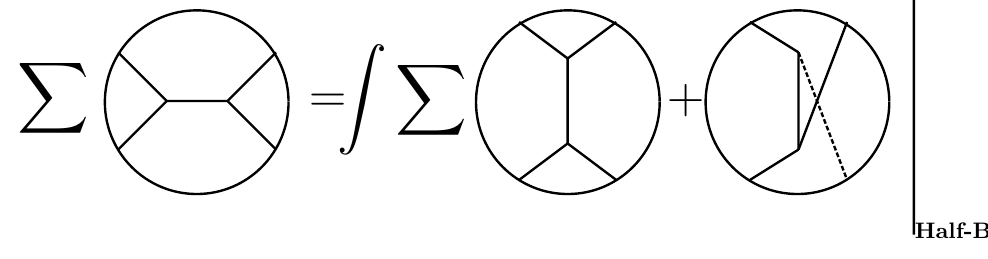
Figure 2 . s -channel OPE data for single- and double-traces can be reconstructed from cross- channel single-traces using the inversion formula. In particular, demanding crossing symmetry unique (cid:12)xes single-trace three-point